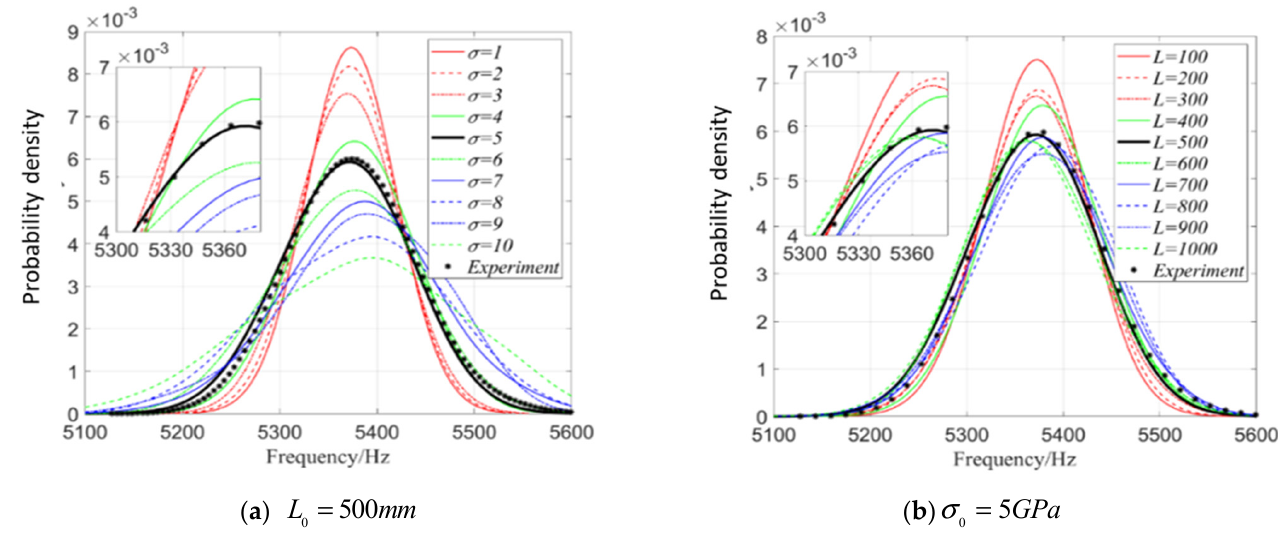
f when only considering ran- 2